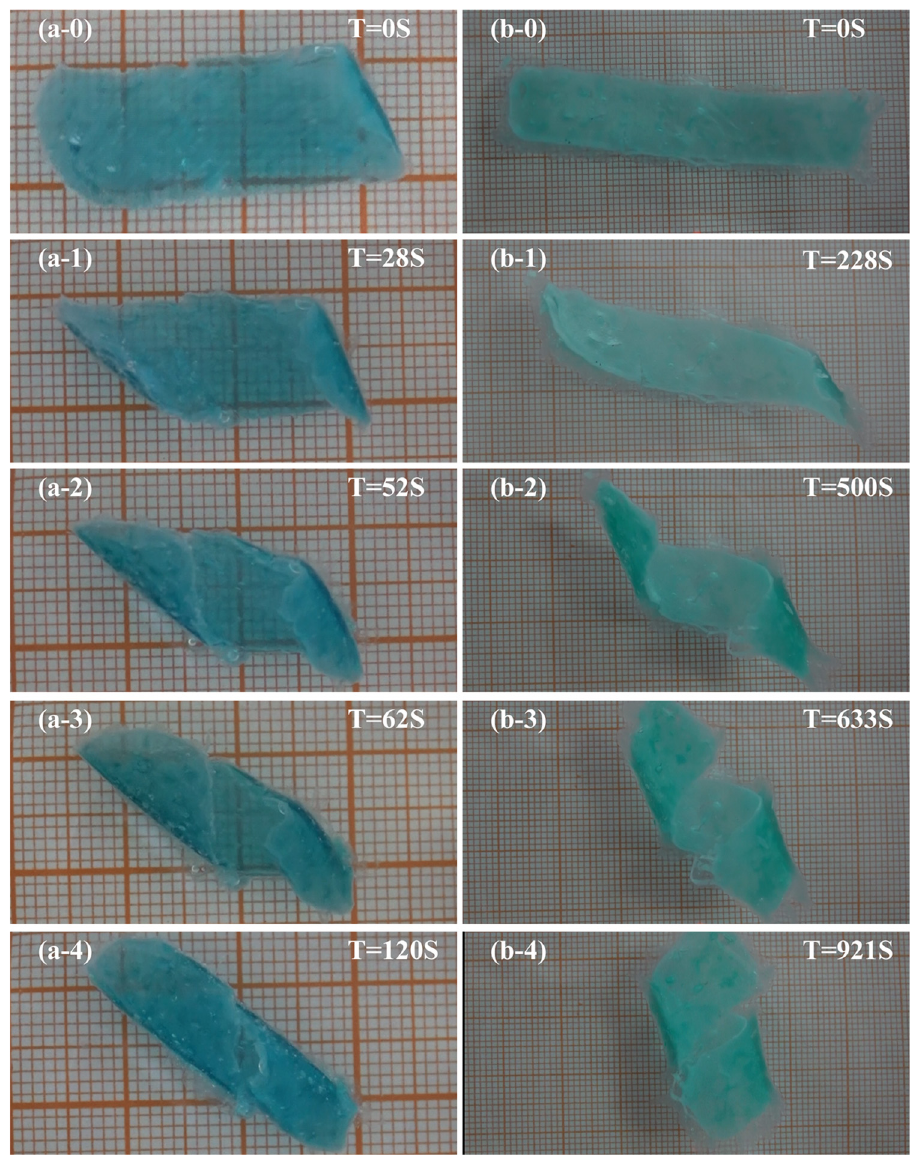
Figure 7: E ff ect of length – width ratio of ( a - 0 ) – ( a - 4 ) 3:1 and ( b - 0 ) – ( b - 4 ) 4:1 on deformation characteristics of intelligent PDMAA